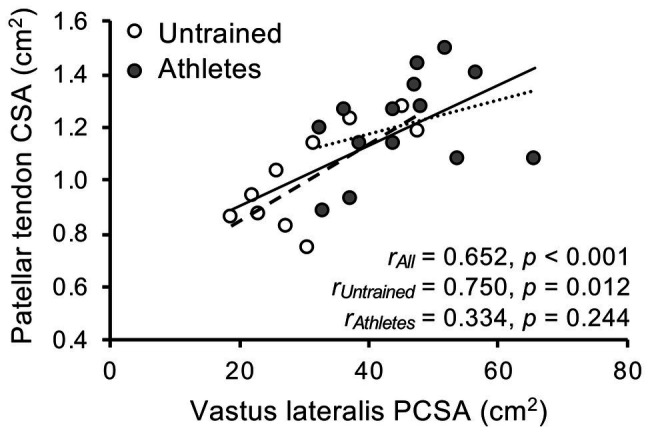
Association of vastus lateralis physiological cross-sectional area and patellar tendon cross-sectional area (CSA) in adolescent athletes (gray; n = 14) and untrained controls (white; n = 10).